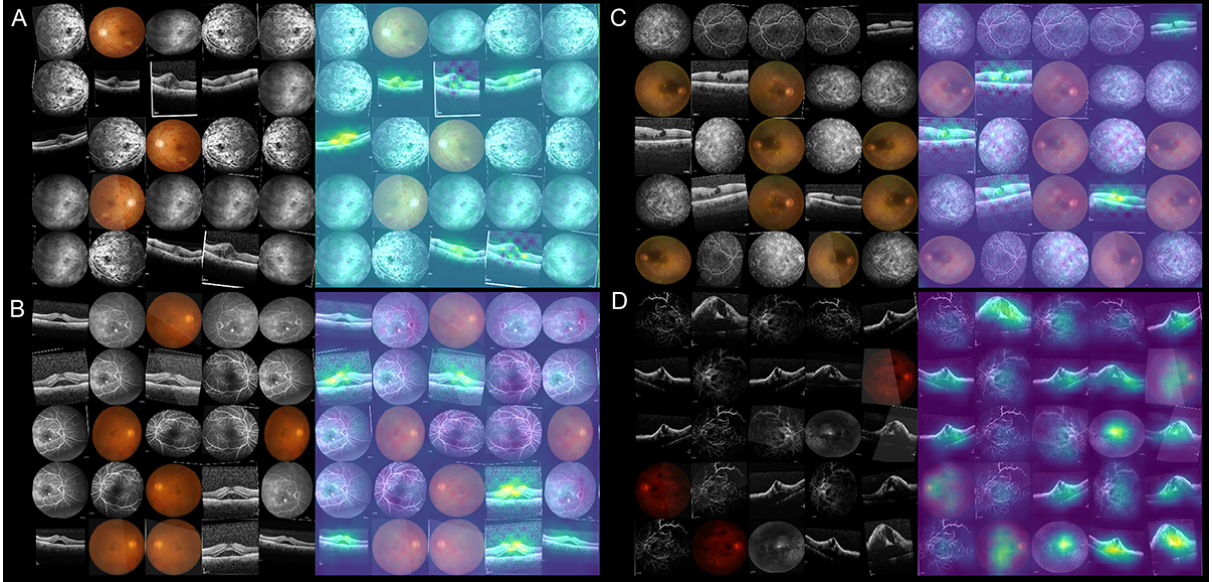
Figure 6. Sample heat maps for false prediction of the model: (A) false prediction of treatment-requiring diabetic macular edema (DME) in a patient with coexisting DME and central retinal vein occlusion (CRVO); (B) false prediction of treatment-requiring age-related macular degeneration (AMD) in a patient with central serous chorioretinopathy; (C) false prediction of treatment-requiring DME in a patient with epiretinal membrane, lamellar macular hole, and diabetic retinopathy; (D) false prediction of treatment-requiring DME in a patient with advanced